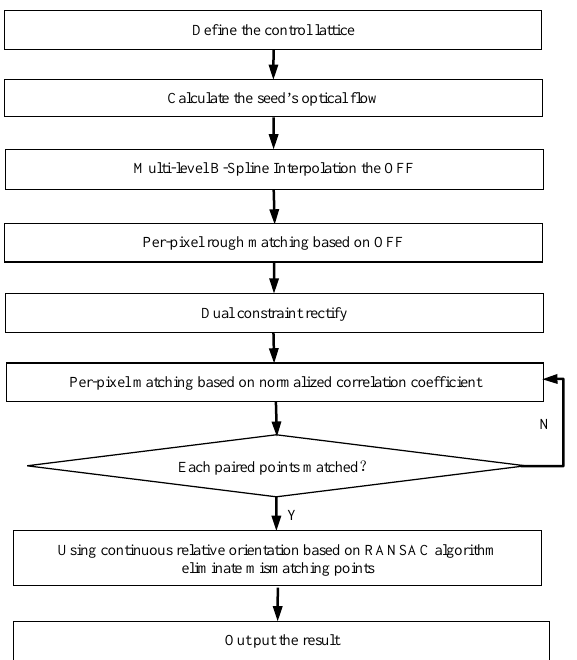
Figure 1. The matching strategy of proposed